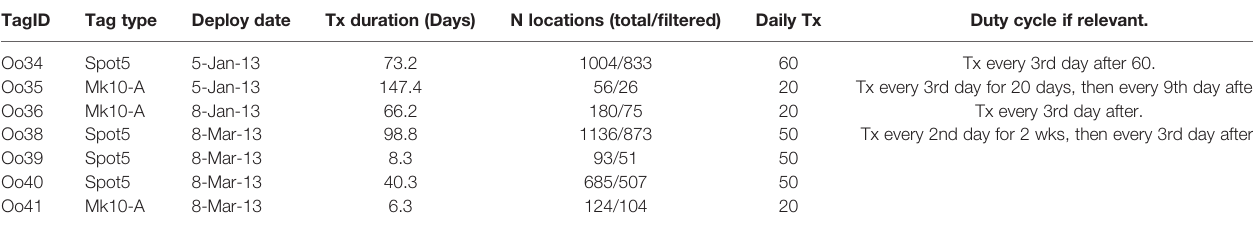
TABLE 1 | Deployment details from Offshore killer whales tagged off California (Oo35 – Oo36) and Washington (Oo38 – Oo41),